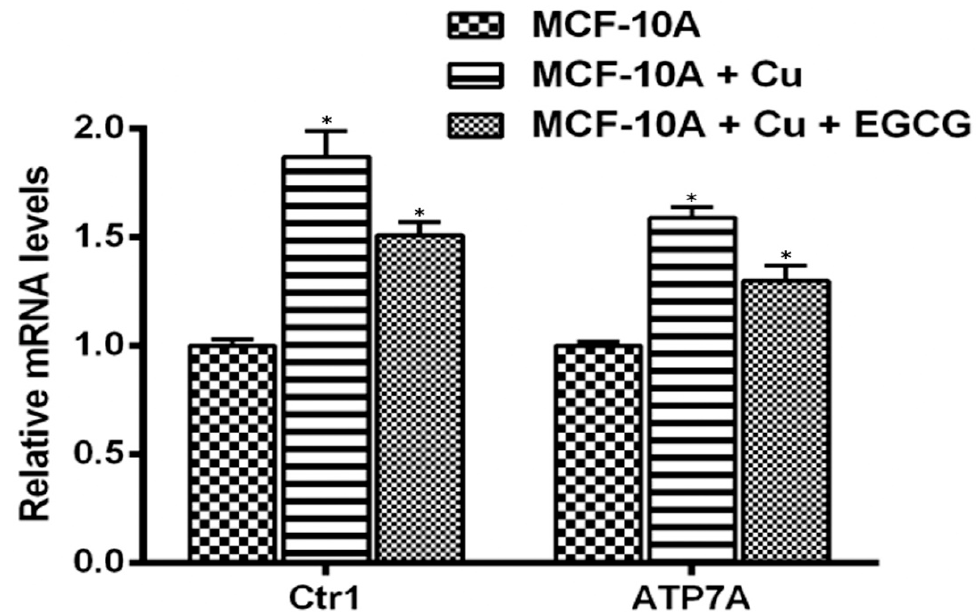
Figure 8. Elevated mRNA transcript levels of copper transporters Ctr1 and ATP7A in MCF-10A-Cu cells, relative to the parental MCF-10A cells, and the effect of EGCG. Total RNA was isolated by using TRIzol reagent (Invitrogen, Carlsbad, CA, USA) according to the manufacturer’s instructions. A real-time PCR was used to quantify Ctr1 and ATP7A mRNA expression as described in the Materials and Methods section. Only MCF-10A-Cu (normal MCF-10A cells cultured in a medium containing 25 µM CuCl 2 ), with elevated mRNA expression of copper transporters, was subjected to treatment with EGCG (50 µM) to assess the effect of EGCG on mRNA expression. Values reported are ± S.E. of three independent experiments. * p value < 0.01 when compared to control.